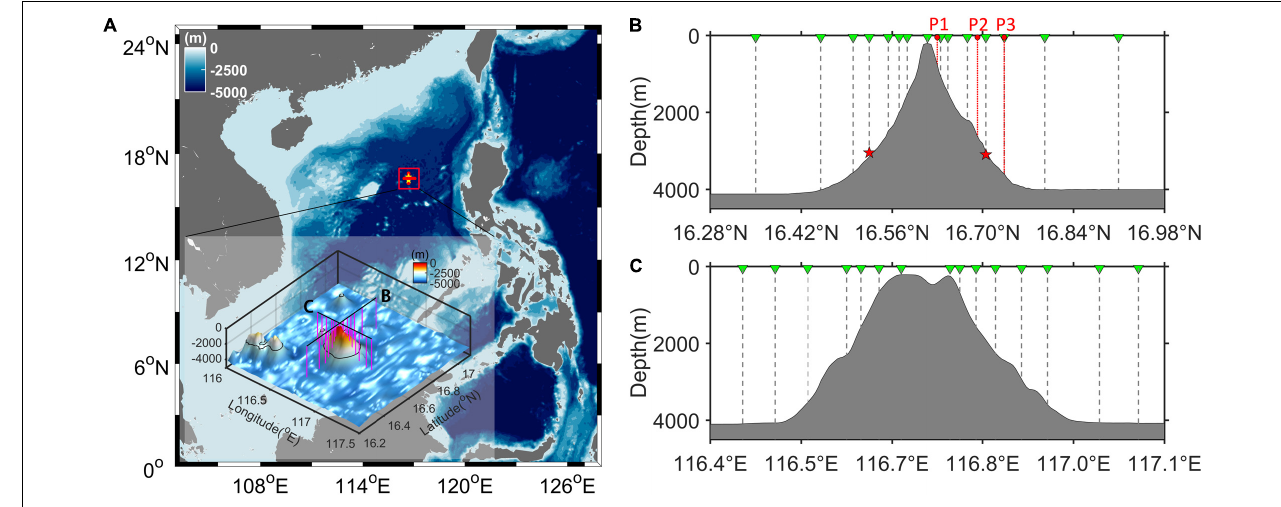
FIGURE 1 | (A) Bottom topography of the SCS based on Smith and Sandwell (1997) with a resolution of 1’. The enlarged map presents the cross-shaped hydrographic section at the seamount. The magenta vertical lines indicate CTD profiles. (B,C) Meridional and zonal sections of the seamount, respectively. The green triangles indicate the CTD profiles, and the red circles indicate the VMP profiles. The red stars display the deep mooring locations.